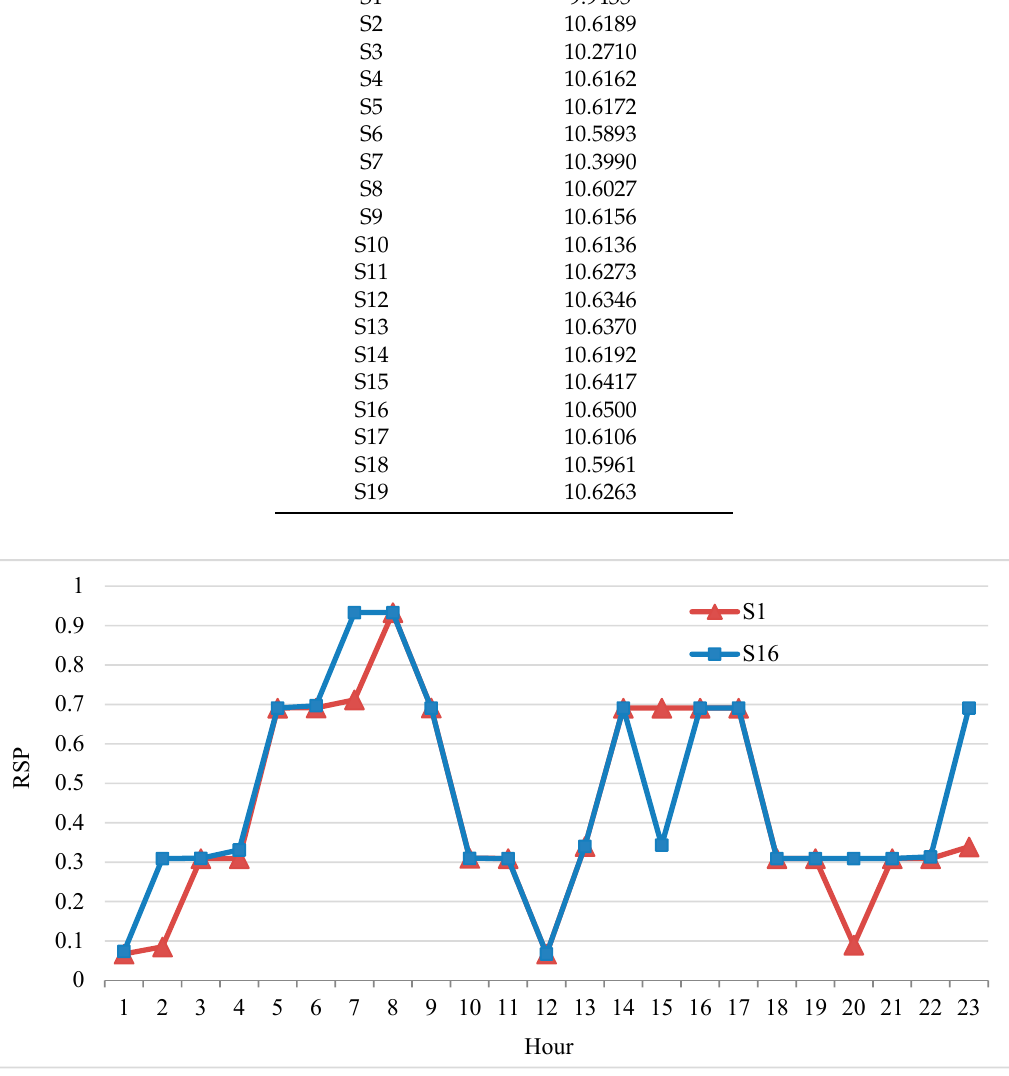
Figure 11. RSP value for S1 and S16.